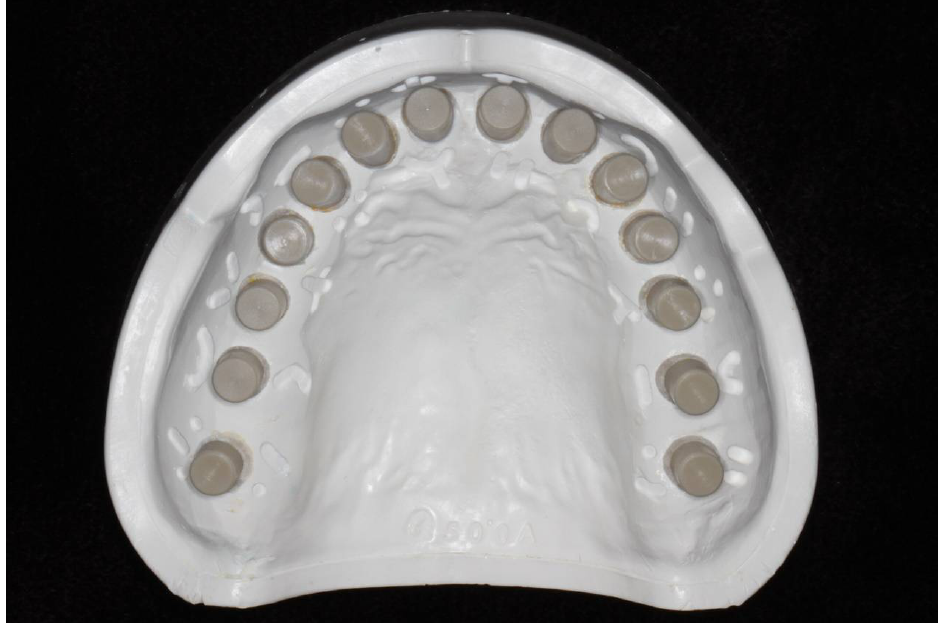
Figure 1. Master model. Irregular patterns were engraved around the polyetheretherketone cylinders to differentiate each cylinder.